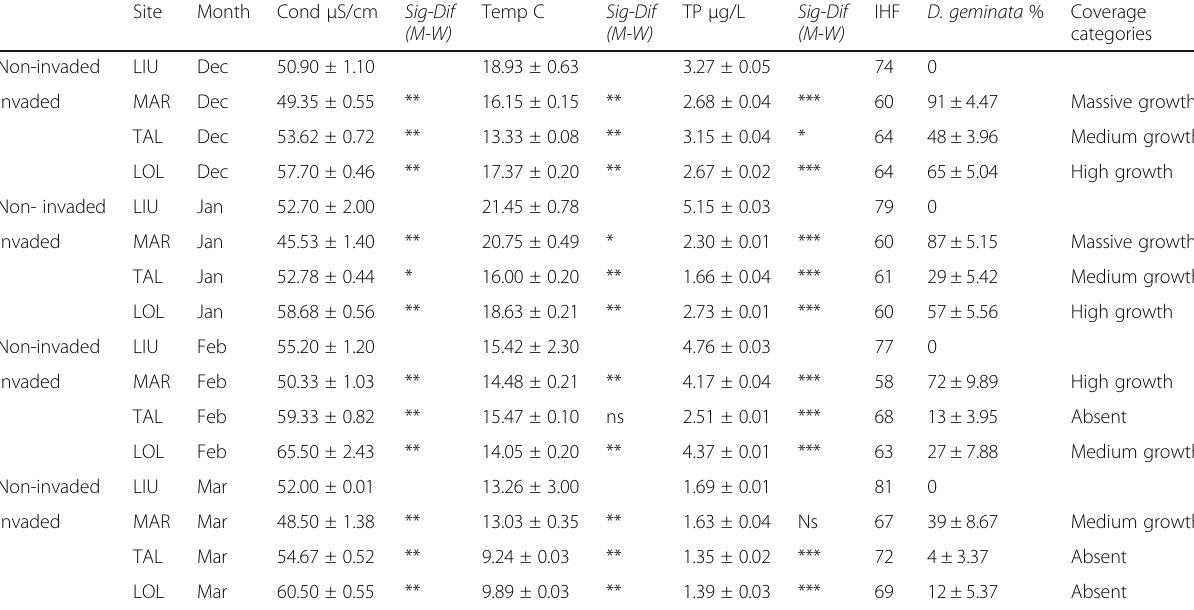
Table 1 Mean values and standard deviation of the most significant environmental variables according to the multivariate linear model. Values of the River habitat index (IHF), D. geminata coverage, coverage categories described by Diaz et al. (2013) and the significant Mann-Whitney U test (***: p < 0.001, **: p < 0.01; *: p < 0.05; ns: